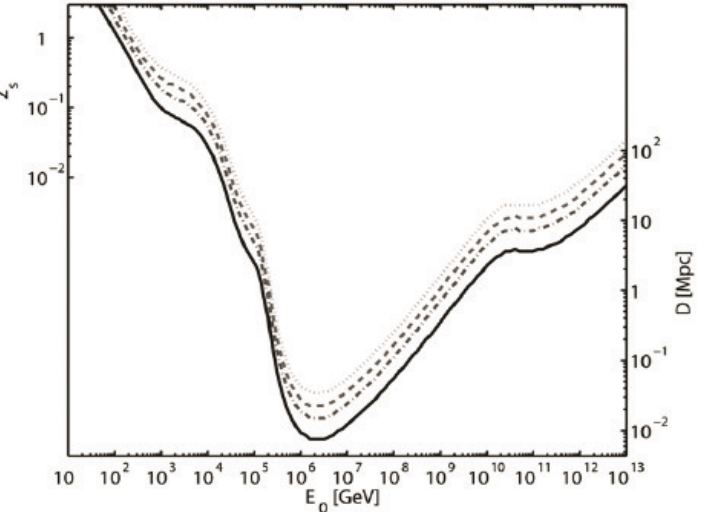
Figure 5. Graphical representation of the global photon–photon opacity. The graph shows the source redshifts z s at which the optical depth takes fixed values as a function of the observed hard photon energy E 0 ; the y-scale on the right side shows the distance in Mpc for nearby sources. The curves from bottom to top correspond to a photon survival probability of e − 1 = 0.37 (the horizon), e − 2 = 0.14, e − 3 = 0.05 and e − 4.6 = 0.01. For D > 8 kpc the photon survival probability is larger than 0.37 for any value of E 0 . (Kind permission by